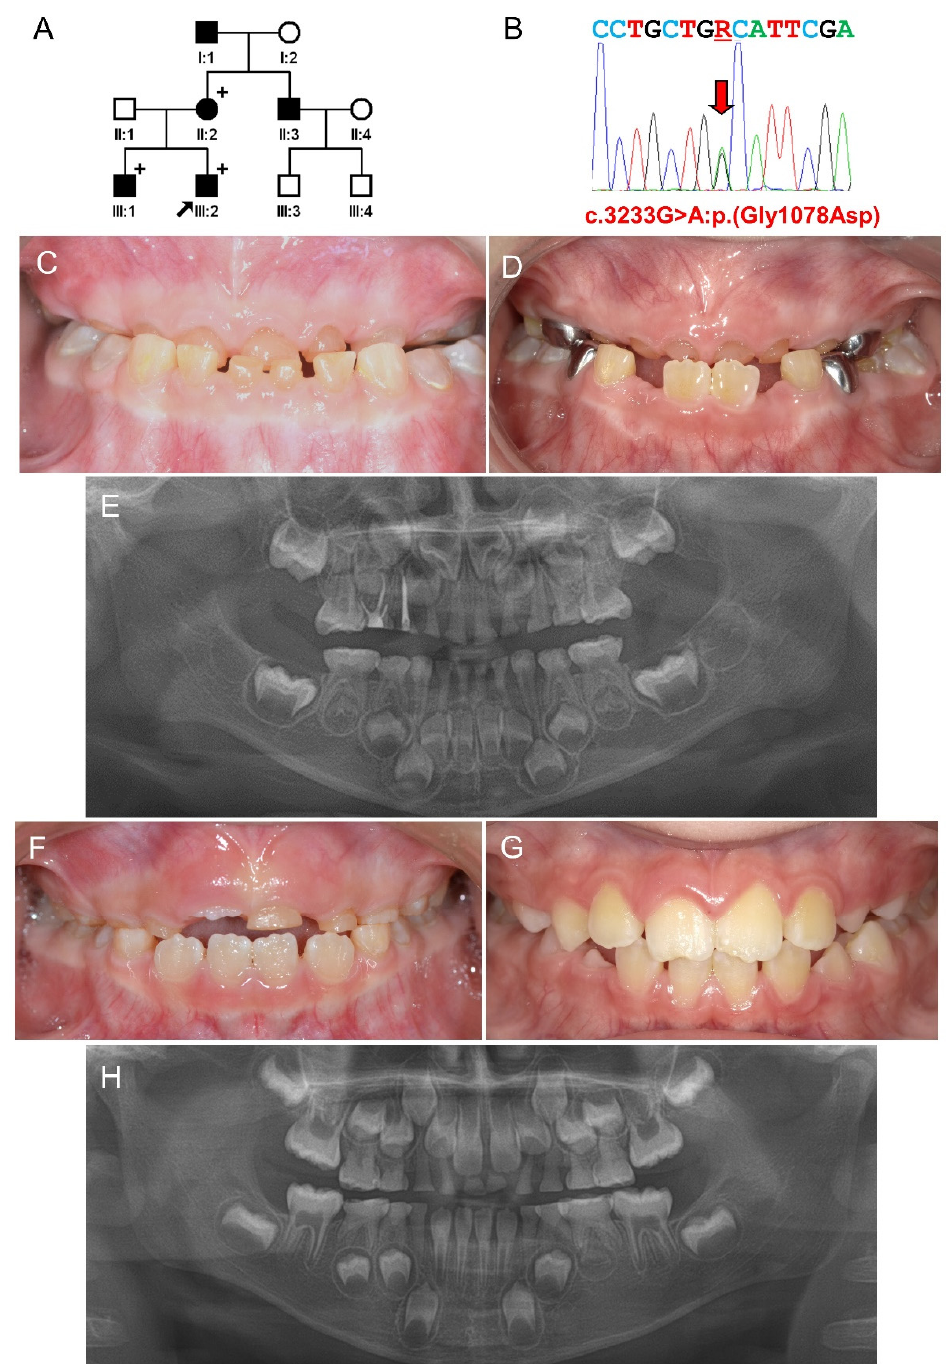
Figure 1. Pedigree, sequencing chromatogram, clinical photos, and panoramic radiograph of Family 1. ( A ) Pedigree of Family 1. Symbol filled black indicates affected individual, and the proband is indicated by a black arrow. Plus signs above the symbols indicate participating individuals. Individual ID is shown below the symbols. ( B ) Sequencing chromatogram of the proband. Nucleotide sequences are shown above the chromatogram. The red arrow indicates the location of the mutation (NM_000089.4:c.3233G>A) (R: A or G). ( C ) Frontal clinical photo of the proband at age 4 years. ( D ) Frontal clinical photo of the proband at age 6 years and 7 months. ( E ) Panoramic radiograph of the proband at age 4 years. ( F ) Frontal clinical photo of the proband’s brother at age 6 years. ( G ) Frontal clinical photo of the proband’s brother at age 8 years and 9 months. The incisal edges of the maxillary central incisors were fractured due to an accident. ( H ) Panoramic radiograph of the proband’s brother at age 6 years.